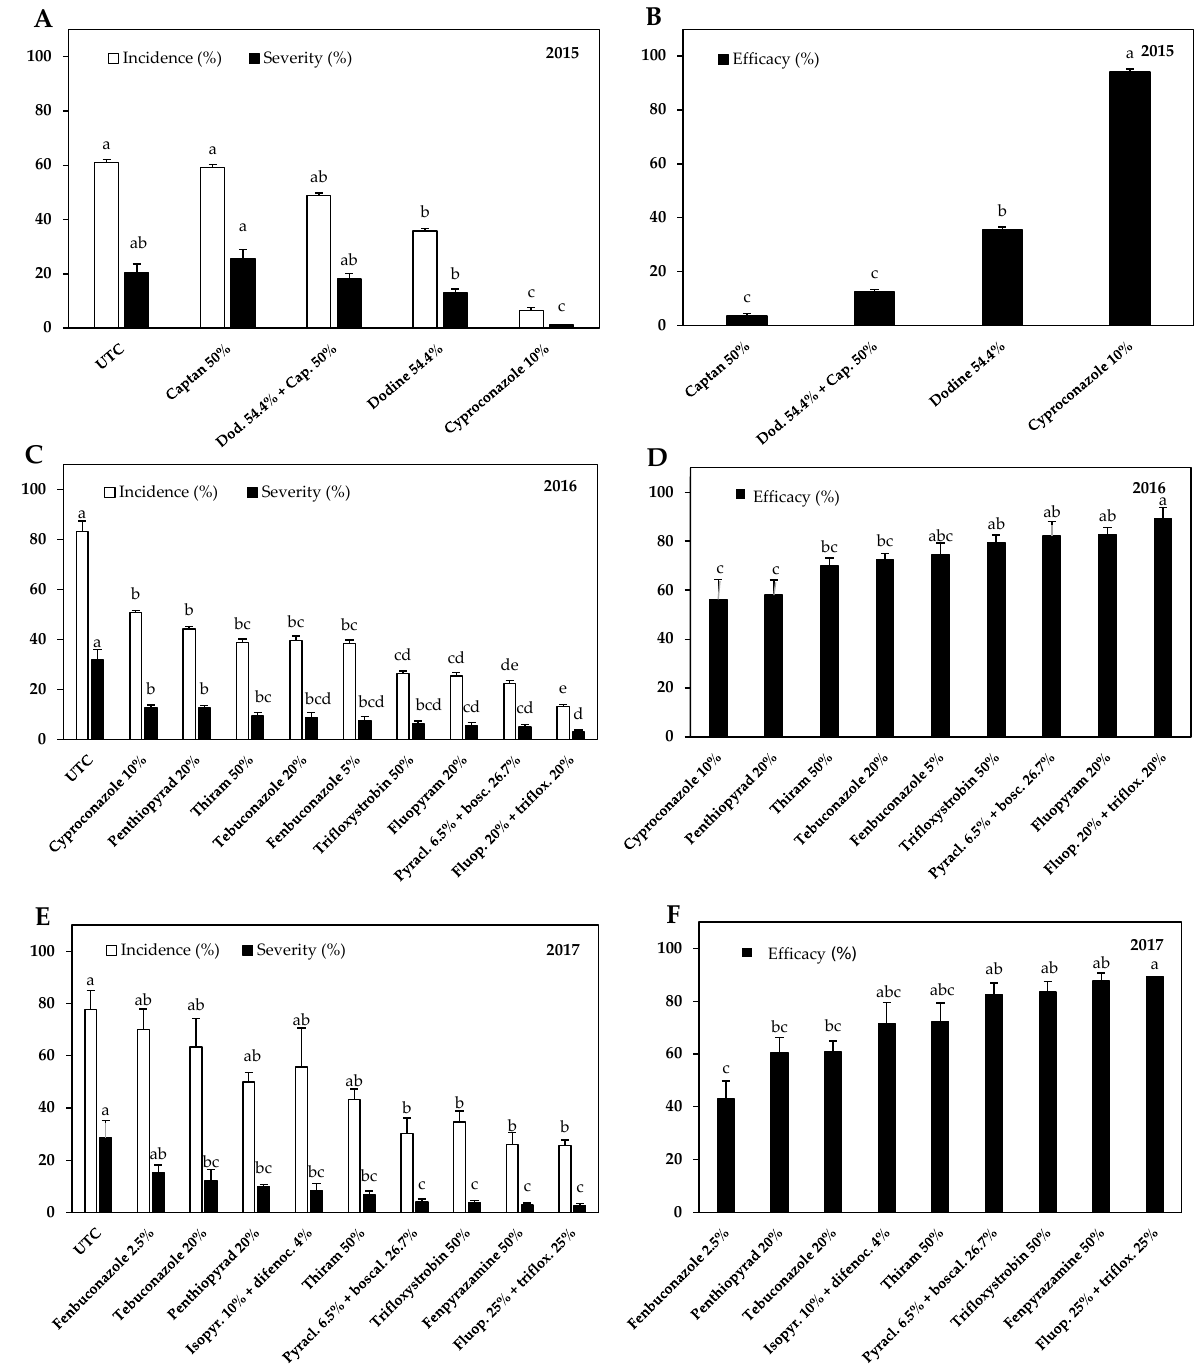
Figure 1. Disease incidence and severity ( A , C , E ) and control efficacy ( B , D , F ) of red leaf blotch in almond trees managed with different contact and systemic fungicides in combination with alternate products (2015–2017). The efficacy was calculated using Abbott’s formula [29]. Treatment means with different letters are significantly different according to Tukey–Kramer’s test ( p < 0.05). The error bars indicate the standard error of the mean.